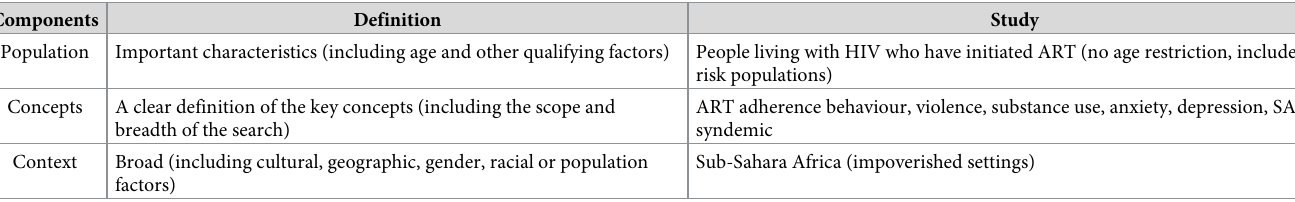
Table 1. Population- concept-context framework